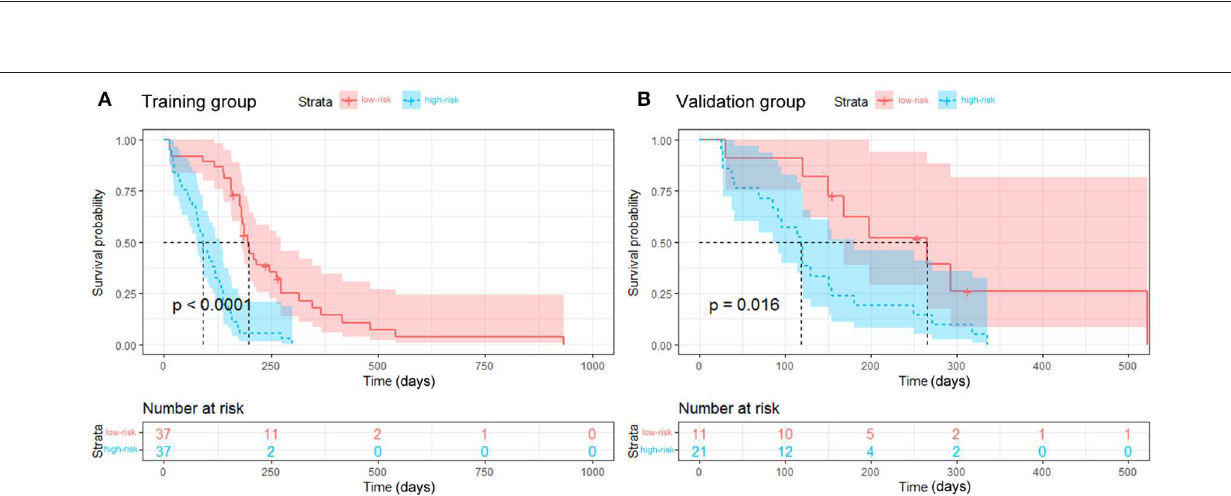
Frontiers in Oncology |